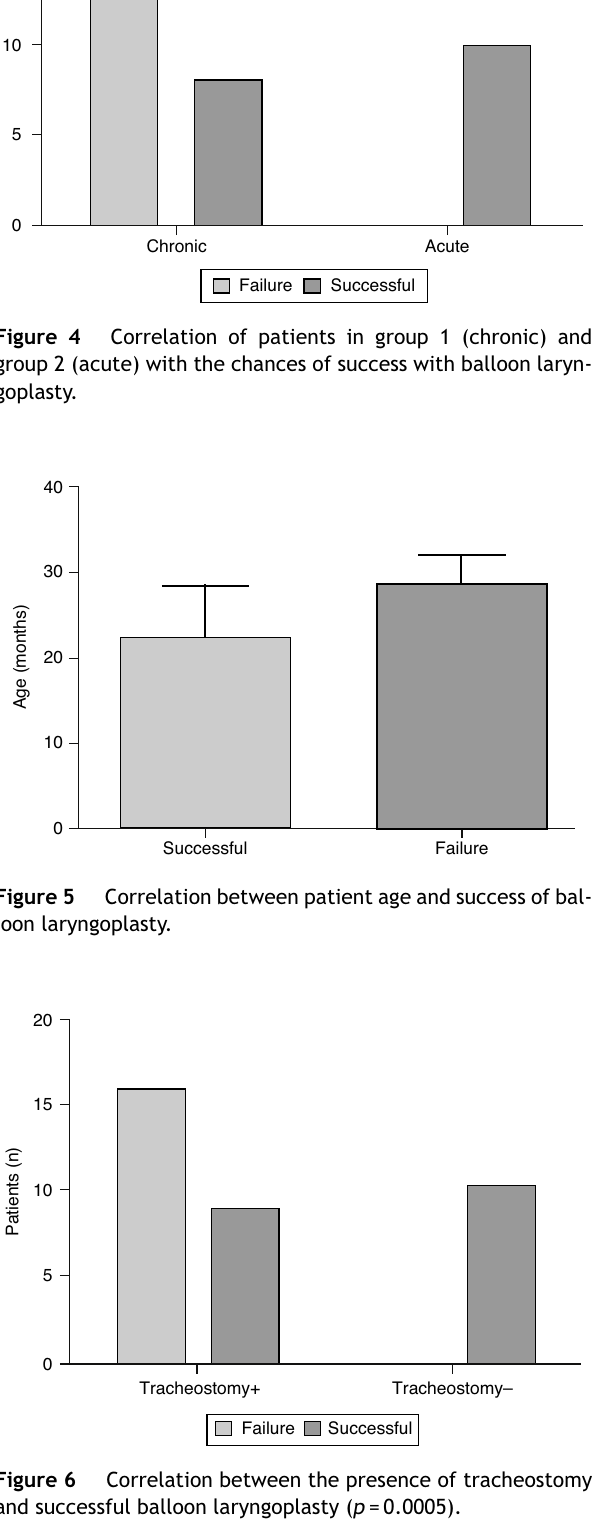
Figure 3 Acute subglottic stenosis. Child with acute grade III SGS, pre-dilatation.